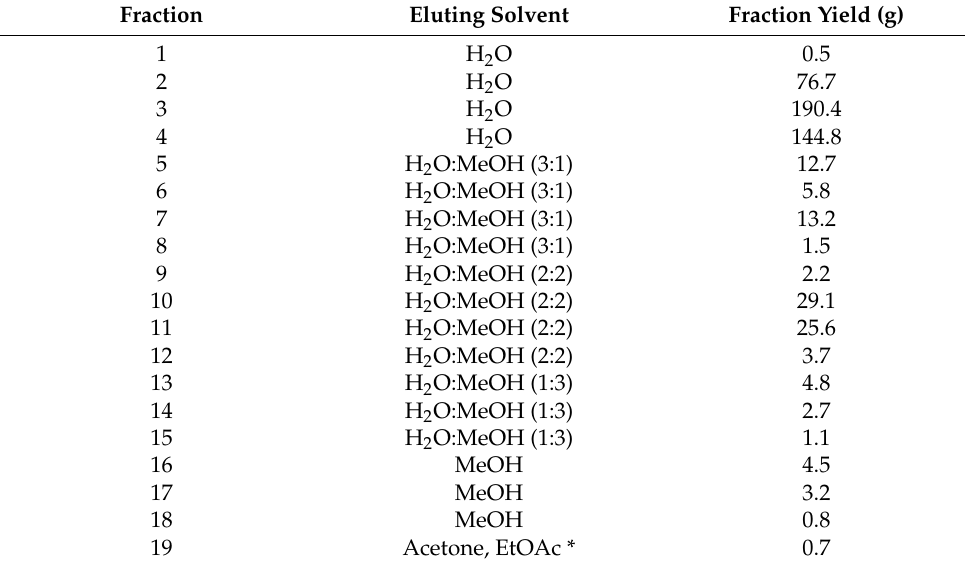
Table 1. Yield of fractions of V. virgatum stem extract separated using HP-20 column chromatography. Fraction Eluting